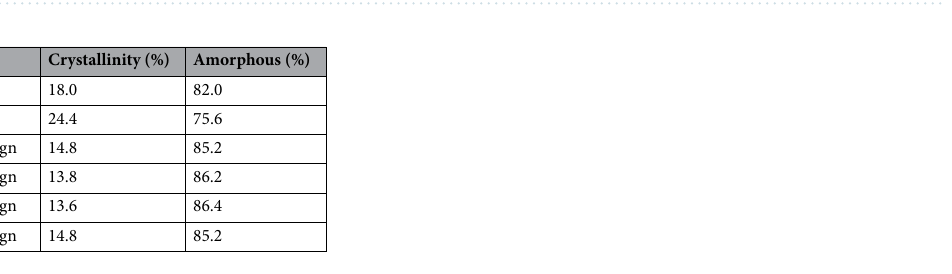
Table 1. Crystallinity and amorphous percentage of the non-crosslinked and genipin-crosslinked gelatin hydrogels.